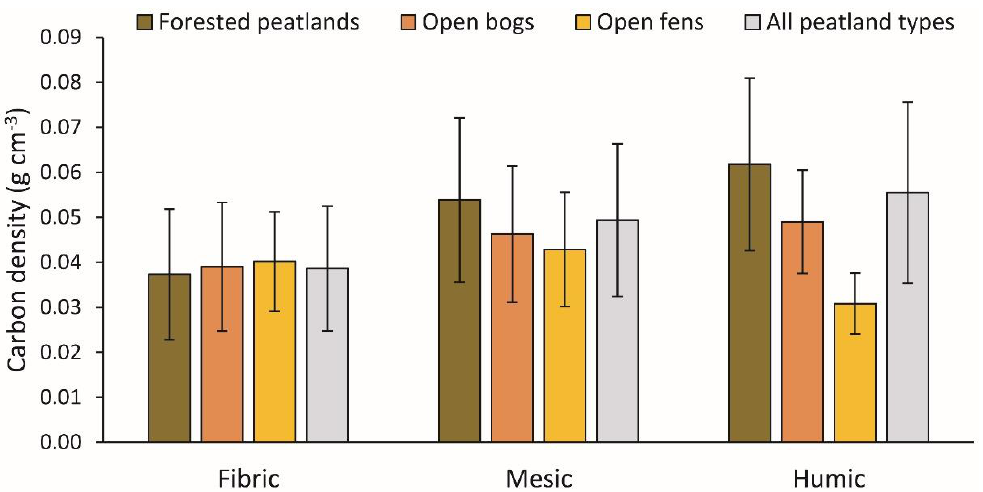
Figure 7. Mean (±SD) carbon density of peat samples (n=776) for the three main classes of humification. Fibric (von Post H1–H4) = weakly humified; Mesic (von Post H5–H6) = moderately humified; Humic (von Post H7–H10) = highly